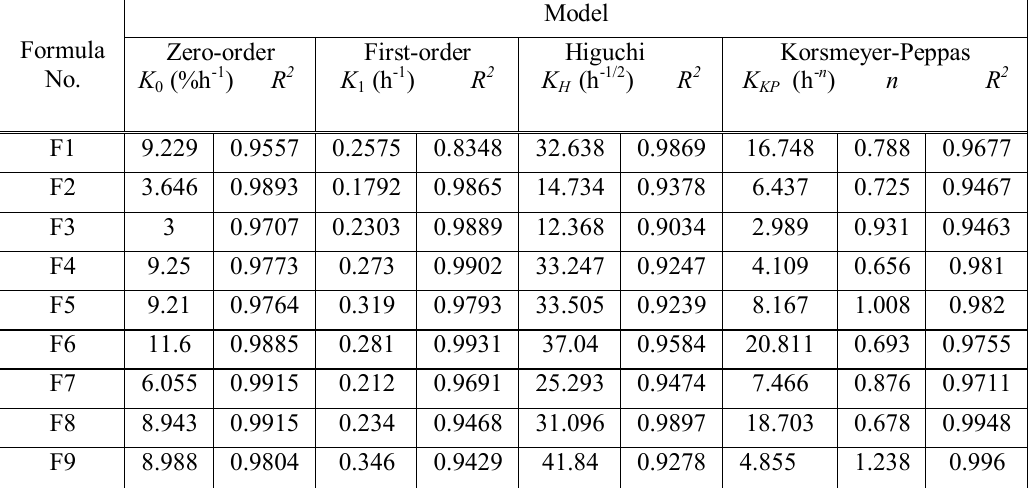
Table 5: Fitting results of formulas 1-9 for CBZ release data to different kinetic model.